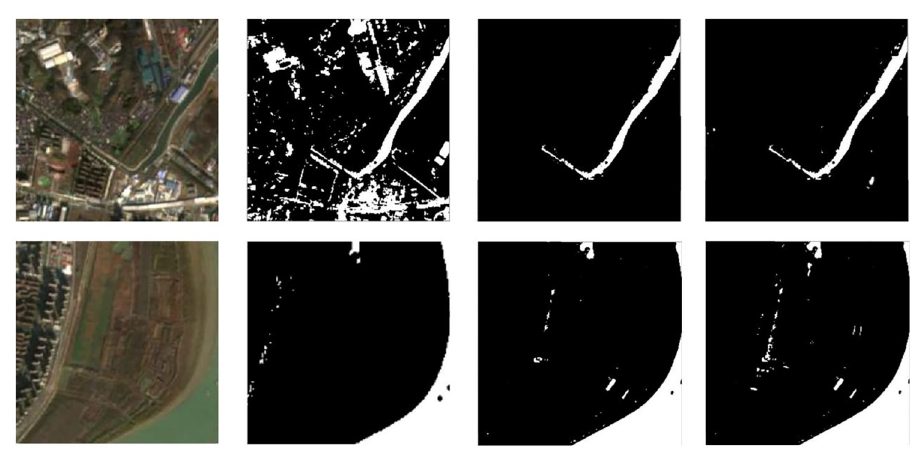
Fig 15. The result of data processing comparison experiment. From left to right, the original image, the result of grayscale transformation, the result of high-pass filtering and the result of this research method. Reprinted from